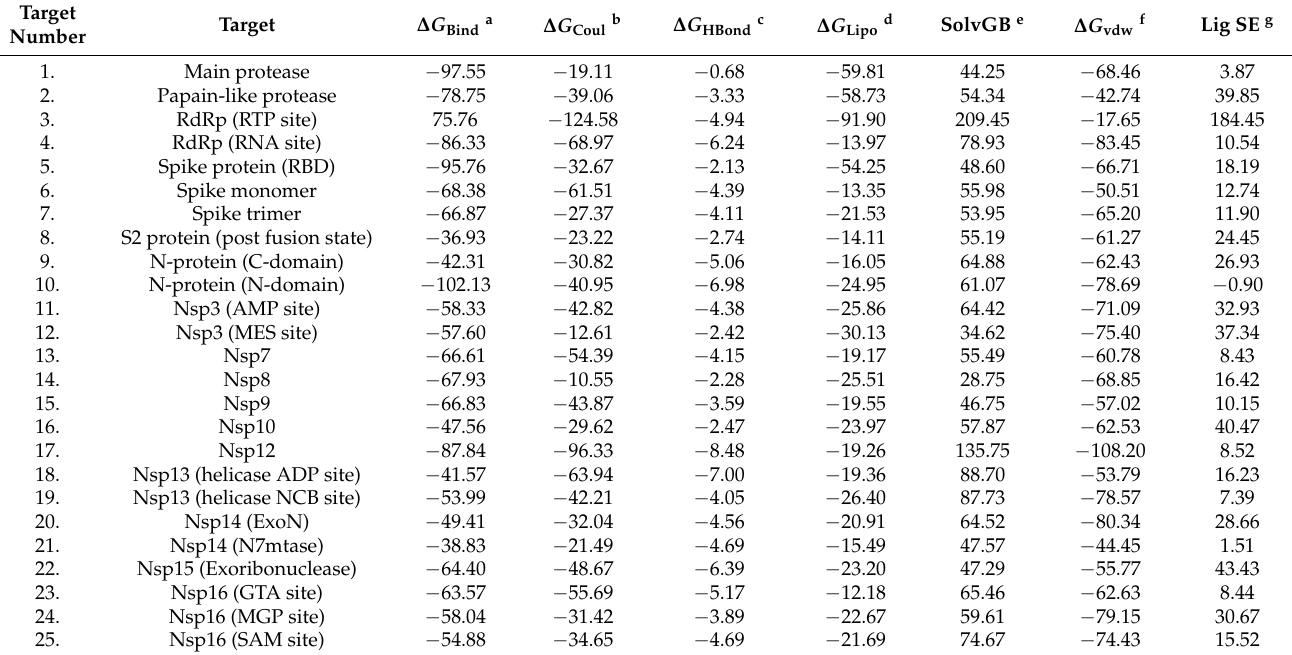
Table 2. Results of molecular mechanics/generalized Born surface area (MM/GBSA) computations for teicoplanin in complex with 25 potential COVID-19